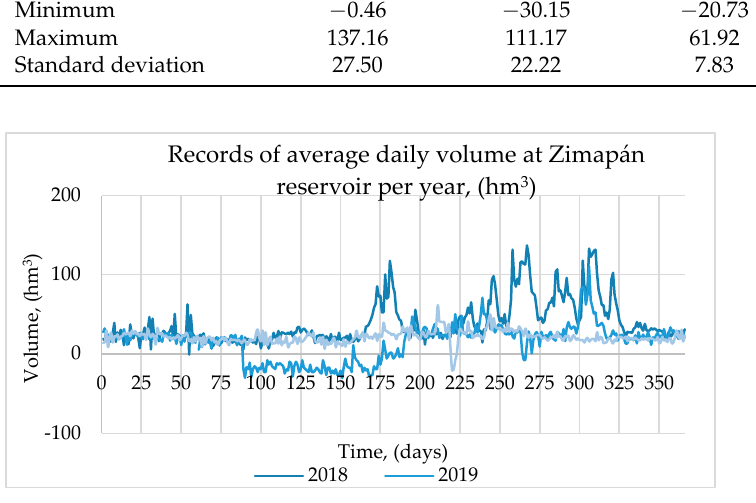
Figure 6. Daily average flow records to the Zimapán reservoir . Own source with hydrological information CFE, 2020.